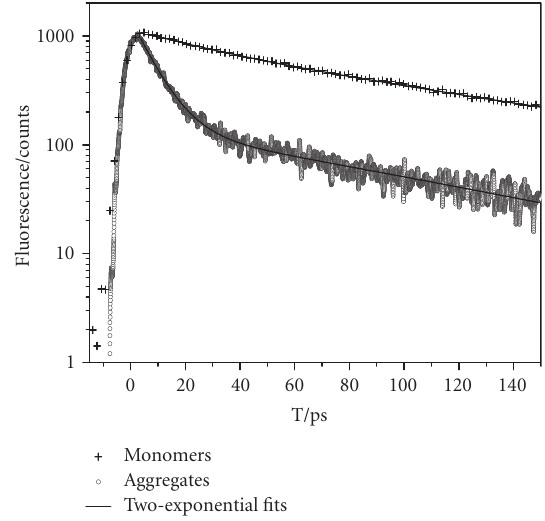
Figure 6: Fluorescence decay of C8O3 monomers (crosses) and ag- gregates (circles) as detected with a streak camera. Solid lines repre- sent two-exponential fits (for details see